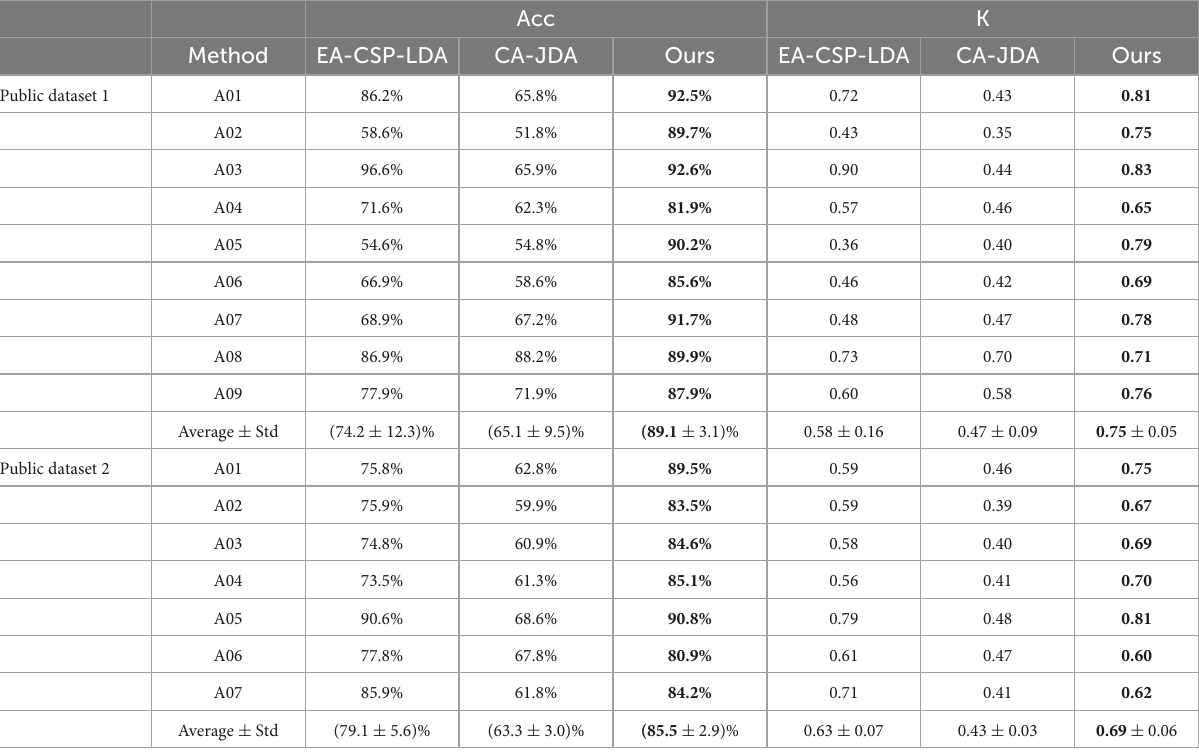
TABLE 1 Results of comparison with state-of-the-art methods on the public dataset 1 and public dataset